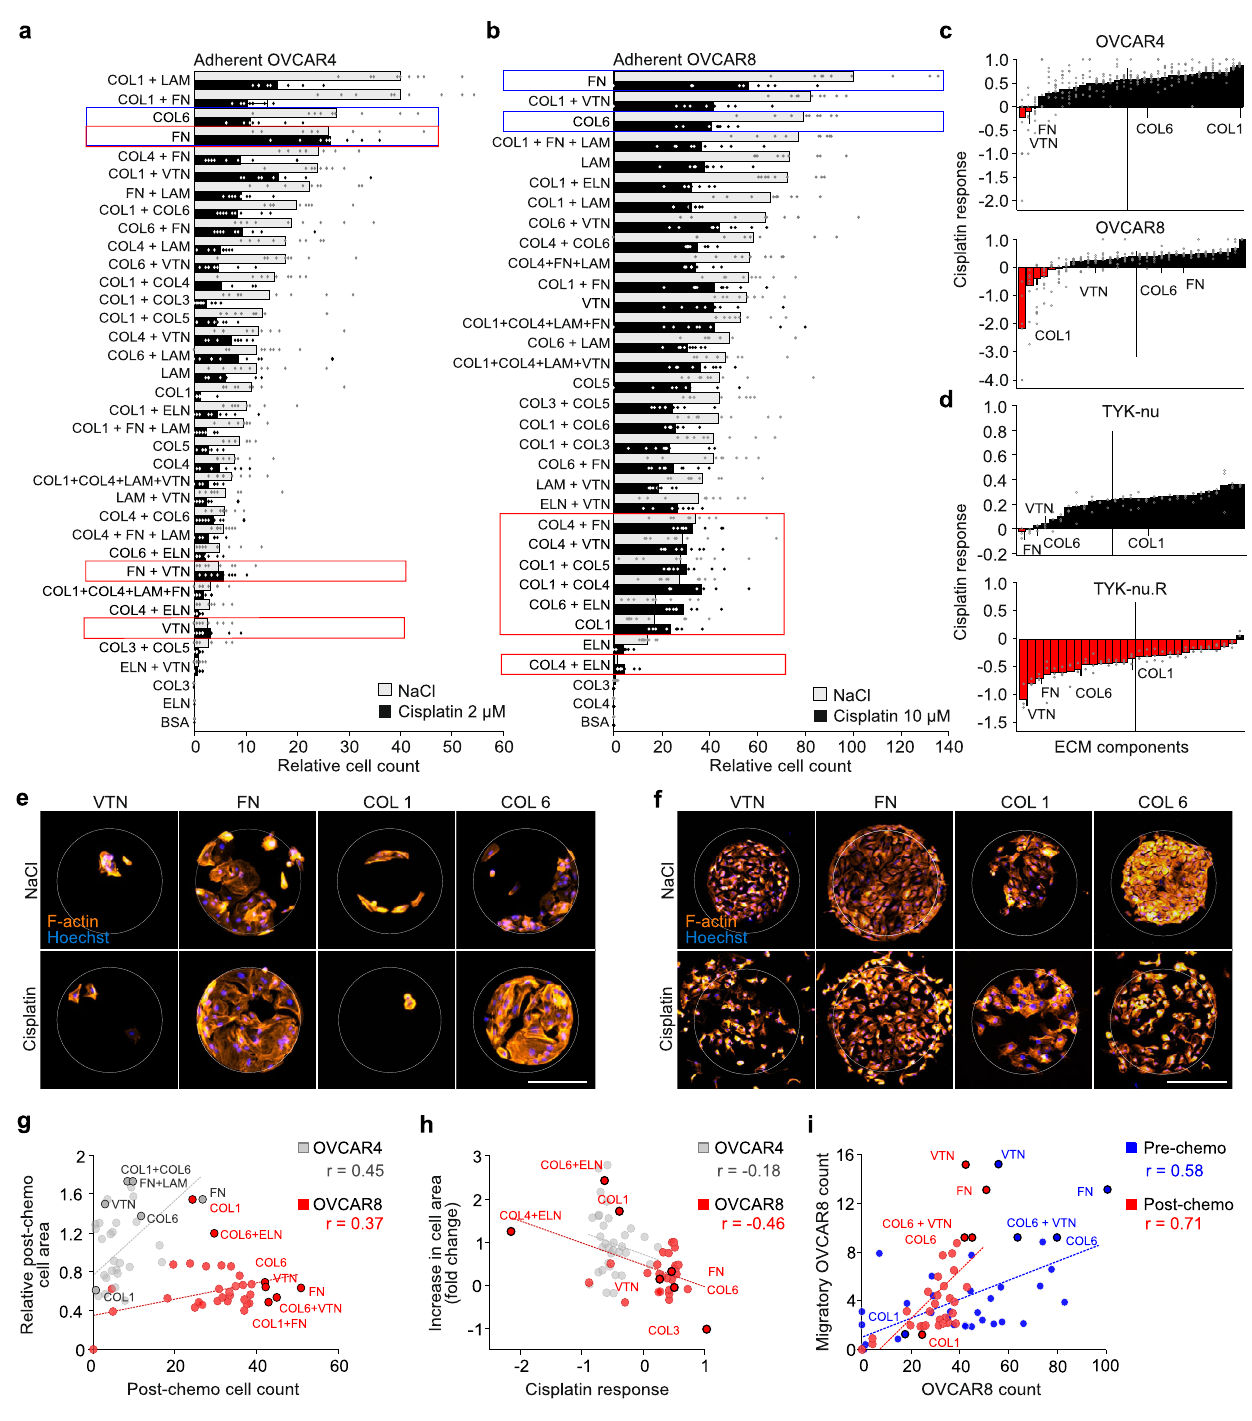
COL6 protein was abundant in HGSC omental metastasis-derived cancer-associated fi broblasts (CAFs; n = 3) as well as in normal human lung fi broblasts (NFs), whereas COL6 protein was low or undetectable in HGSC cell lines and patient-derived HGSC cells (Fig. 5f; n = 3). Furthermore, in omental micro-metastasis ( n = 2) and desmoplastic, metastatic HGSC tissues ( n = 16), COL6 protein expression was abundant, with strong expression particularly in the immediate surroundings of the micrometastatic foci as well as in the stroma of early and established metastatic tumors (Fig.